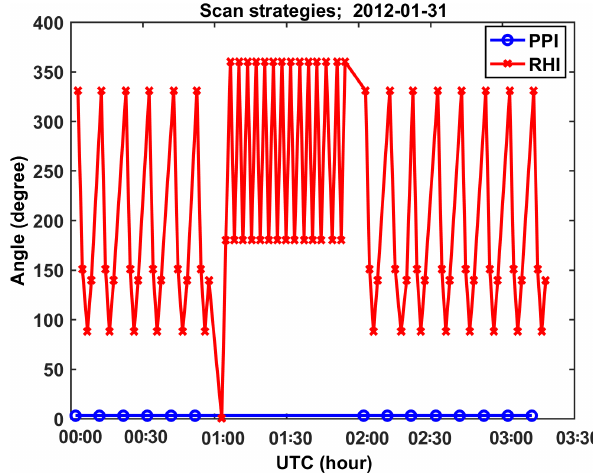
Figure 7. D3R scan strategies on 31 January 2012. The y axis is azimuth angle (RHI; red x) or elevation angle (PPI; blue o). The scan rate of RHI was 1 ◦ s − 1 and 10 ◦ s − 1 for PPI.